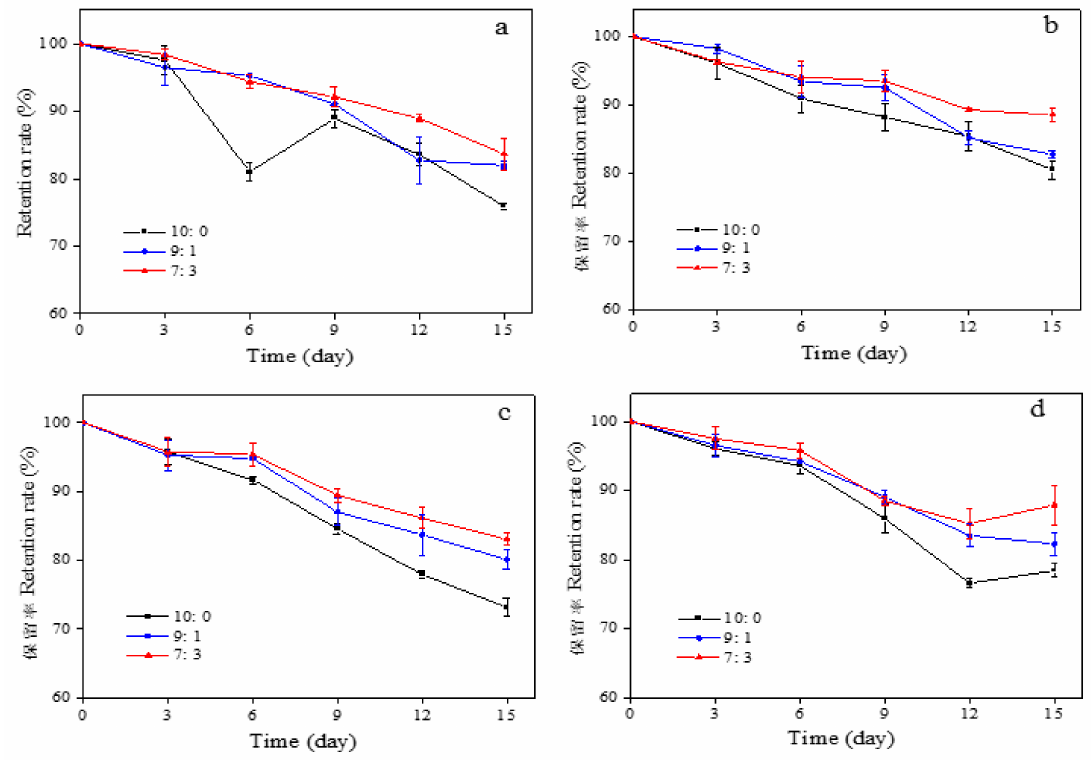
Figure 6. The effect of different storage conditions (( a ) 50 ◦ C in the dark; ( b ) 25 ◦ C in the dark; ( c ) UV light at room temperature; ( d ) sunlight at room temperature) on the retention rate of microcapsules. The labels 10:0, 9:1, 7:3, 5:5, 3:7, and 1:9 represent the ratio of whey protein to citrate mung bean